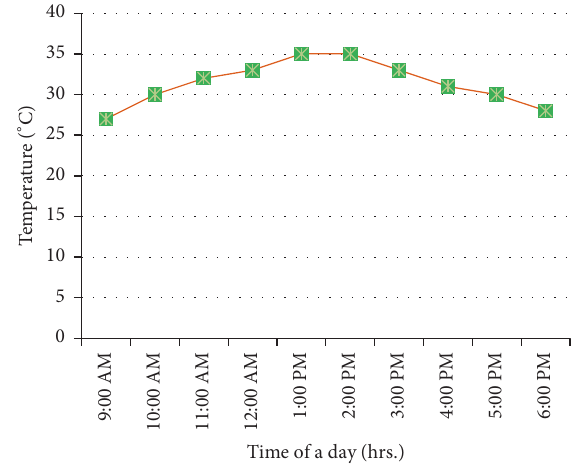
Time of a day (hrs.) Figure 8: Daily temperature variation of a Malaysian sunny day.